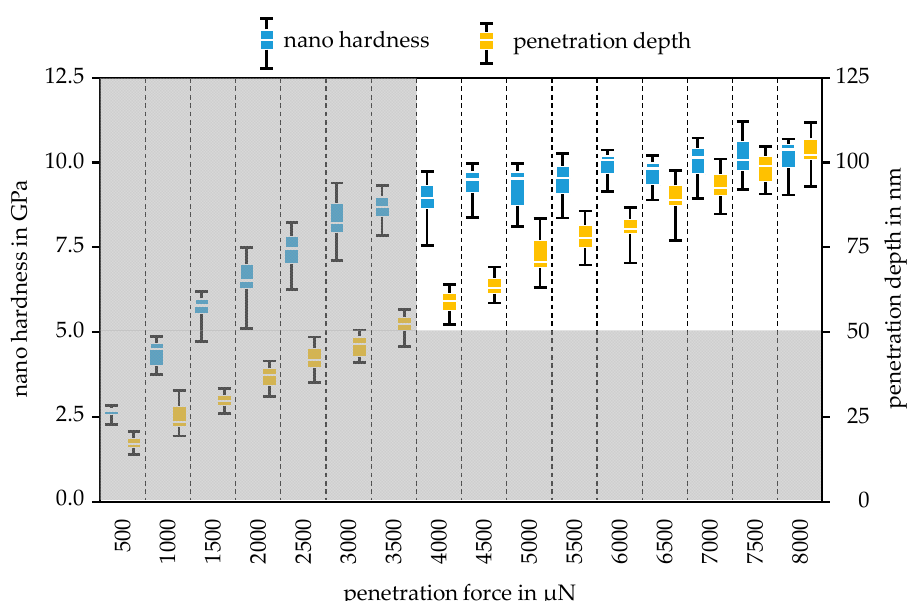
Figure 8. Development of the nano hardness and the penetration depth via the varied penetration forces for the Mo ‐ coating with minimum and maximum values.